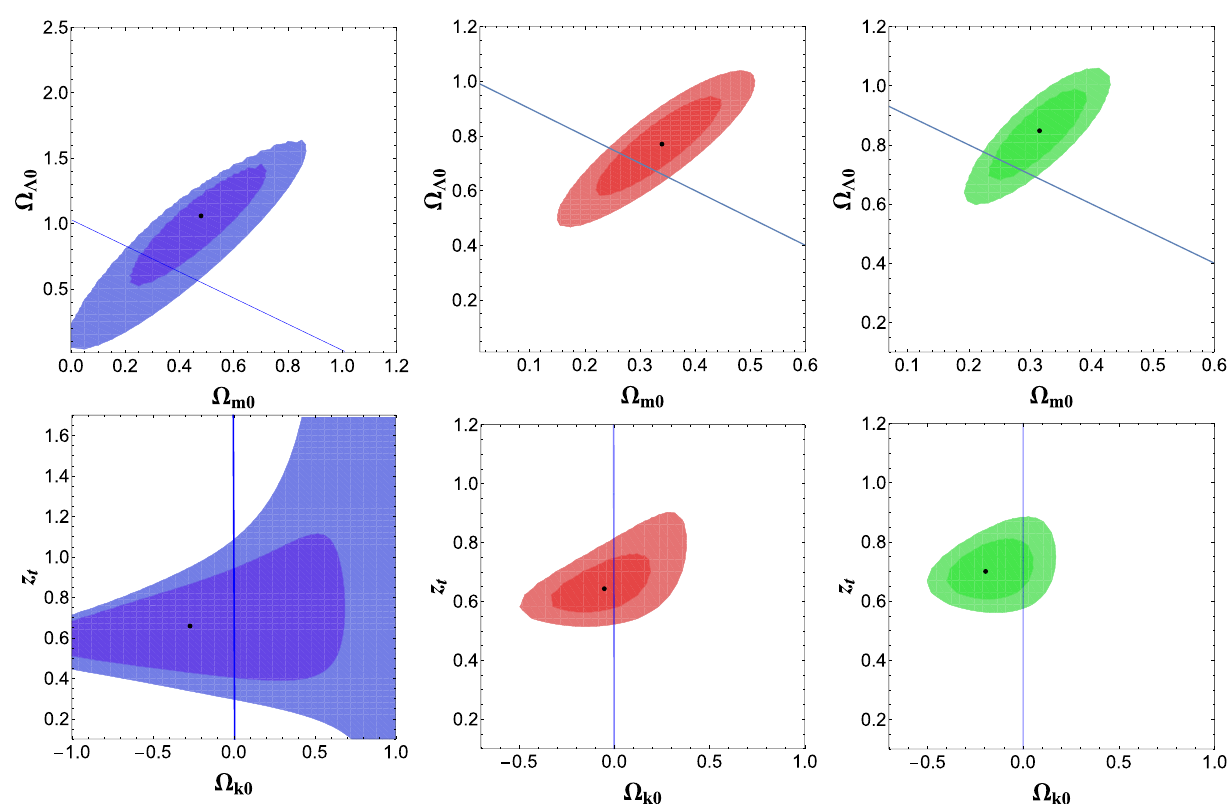
Fig. 2 Observational constraint using Hubble parameters measurements (left) and SNIa (middle). A joint analysis is shown on the right side. In all case we marginalized 50 < H 0 < 80 ) . The blue line represents the universe with flat curvature